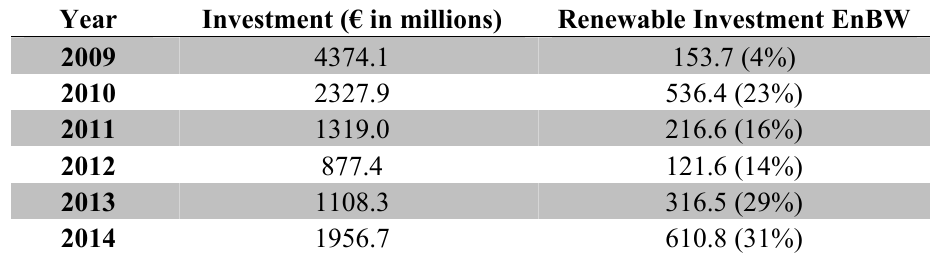
Table 7. EnBW–overall investment and share of investment in renewables